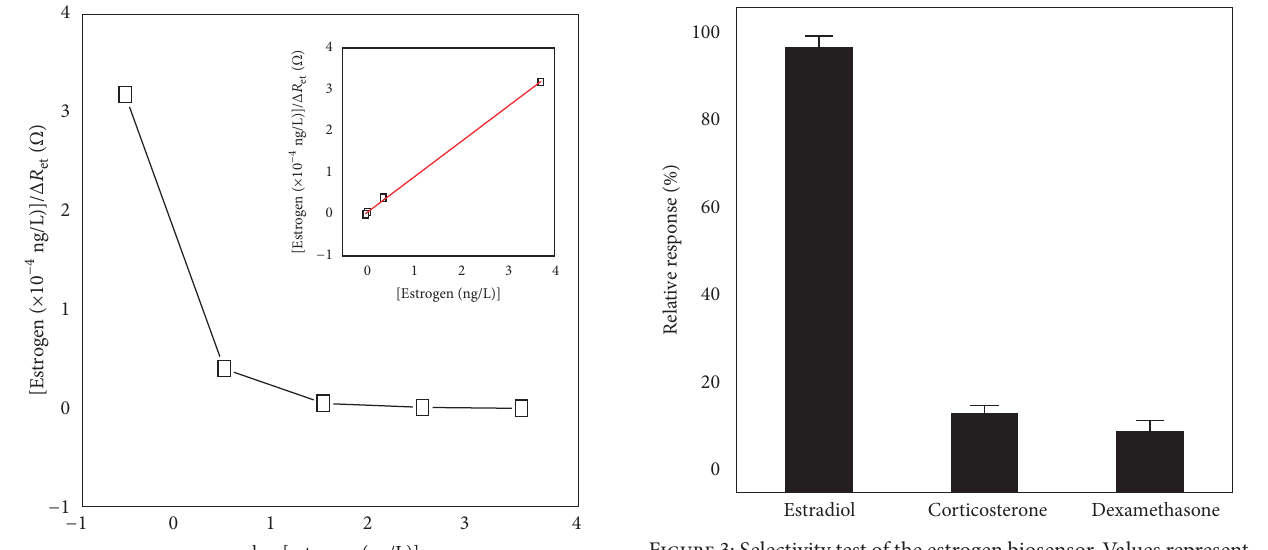
Figure 3: Selectivity test of the estrogen biosensor. Values represent the mean ± standard deviation from three separate